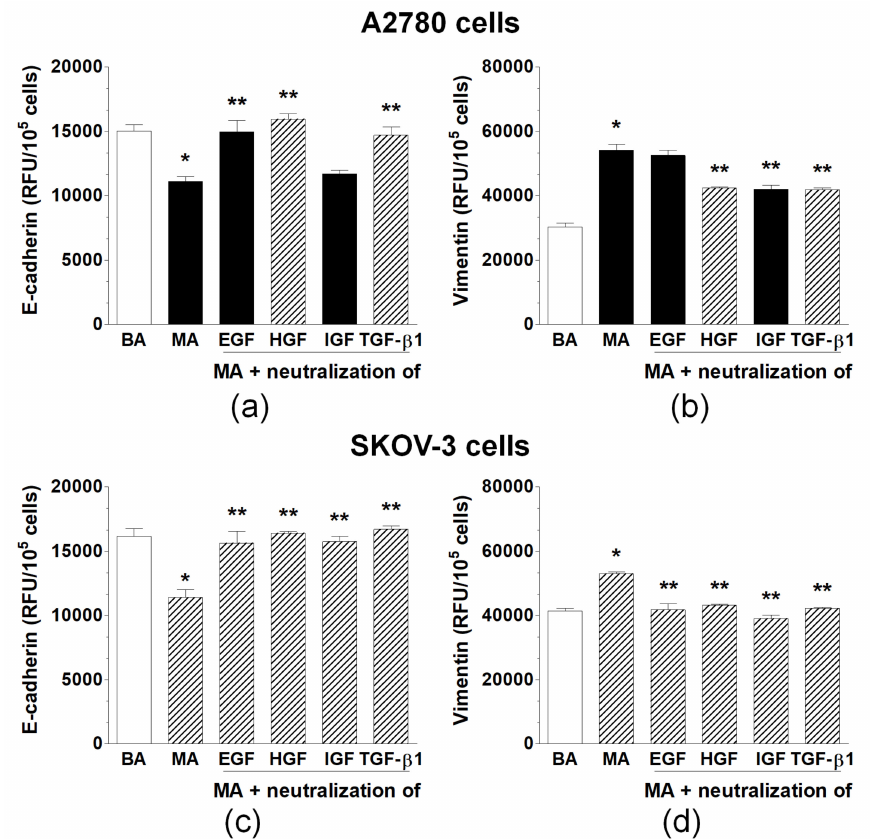
Figure 3. Expression of E-cadherin and vimentin in A2780 ( a , b ) and SKOV-3 cells ( c , d ) exposed to benign ascites (BA), malignant ascites (MA), and MA pre-incubated with specific antibodies against EGF, HGF, IGF, and TGF- β 1. Hatched bars indicate the mediators whose neutralization consistently reversed the MA-dependent changes in the level of E-cadherin or vimentin. Single asterisks (*) indicate significant differences ( p < 0.05) compared with ovarian cancer cells exposed to benign ascites. Double asterisks (**) indicate significant differences ( p < 0.05) compared with the cells exposed to MA. Experiments were performed with the cancer cells used in hexaplicates. The benign and malignant ascites were obtained from eight different patients per group. RFU—relative fluorescence